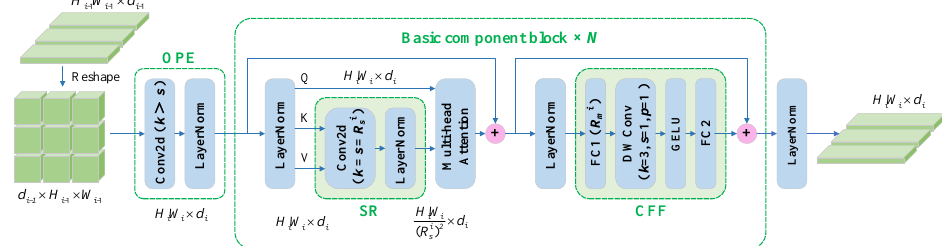
Figure 3. The basic component block of the pyramid vision Transformer (PvT). OPE: overlapping patch embedding, SR: spatial reduction, CFF: convolutional